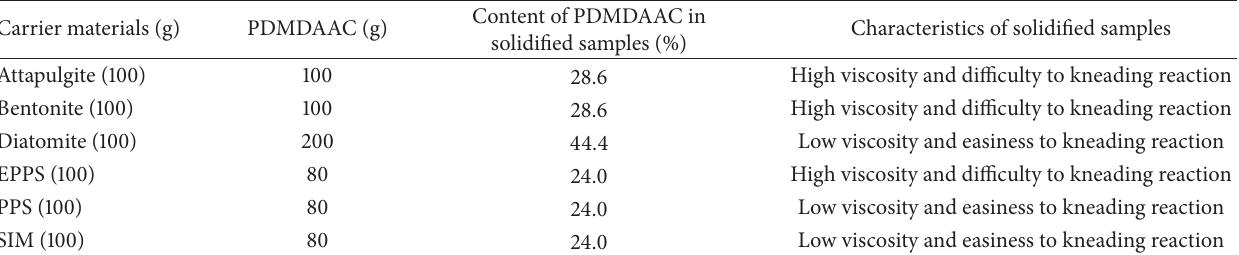
Table 8: The carried dosage of different carrier materials for PDMDAAC. Carrier materials (g)